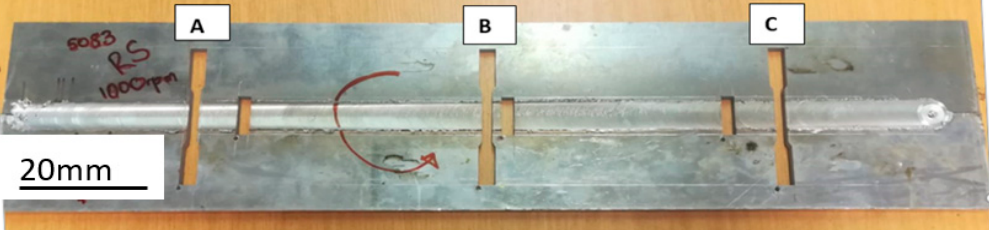
Figure 6. FSW plate showing specimen positioning.